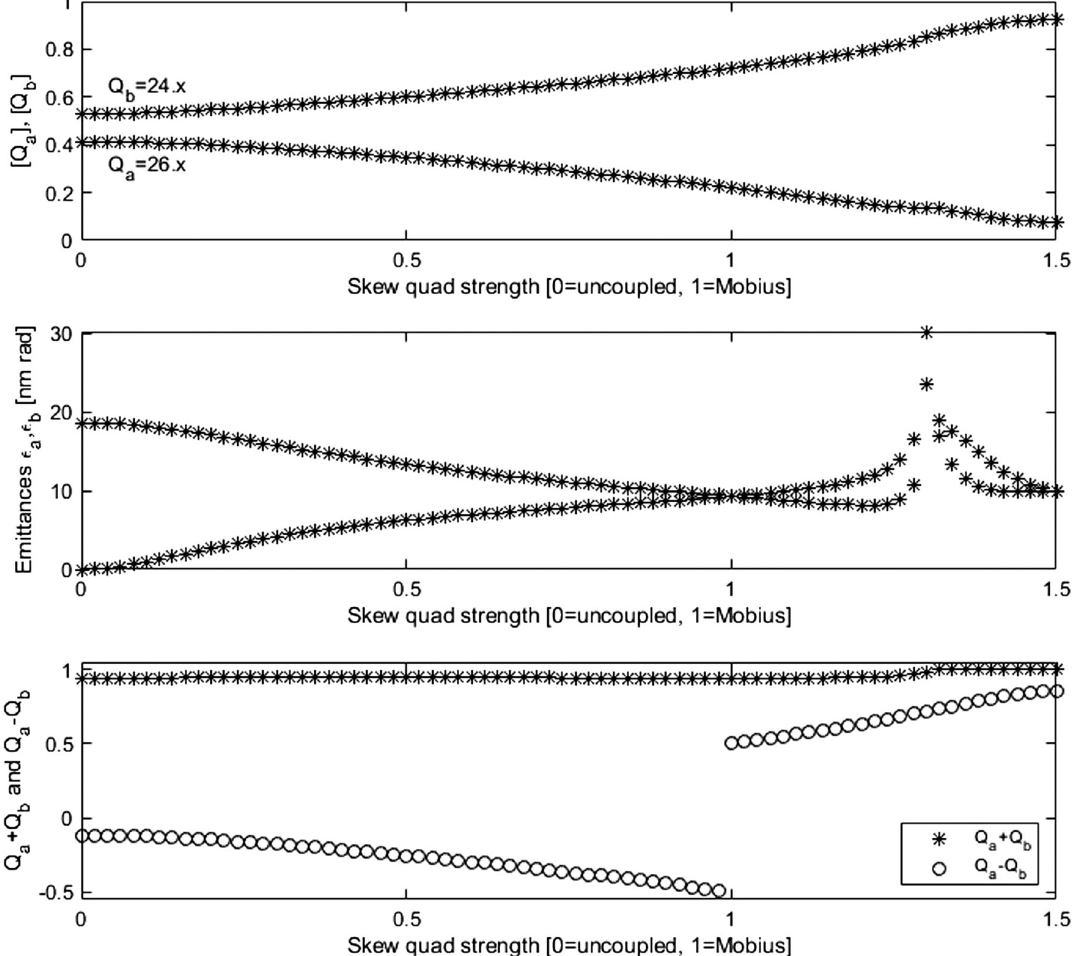
right).FIG. 6. The fractional tunes (top) and the emittances (middle) of the Möbius ring (top) as a function of the excitation of the skew quadrupoles. The bottom panel shows the sum and difference of the